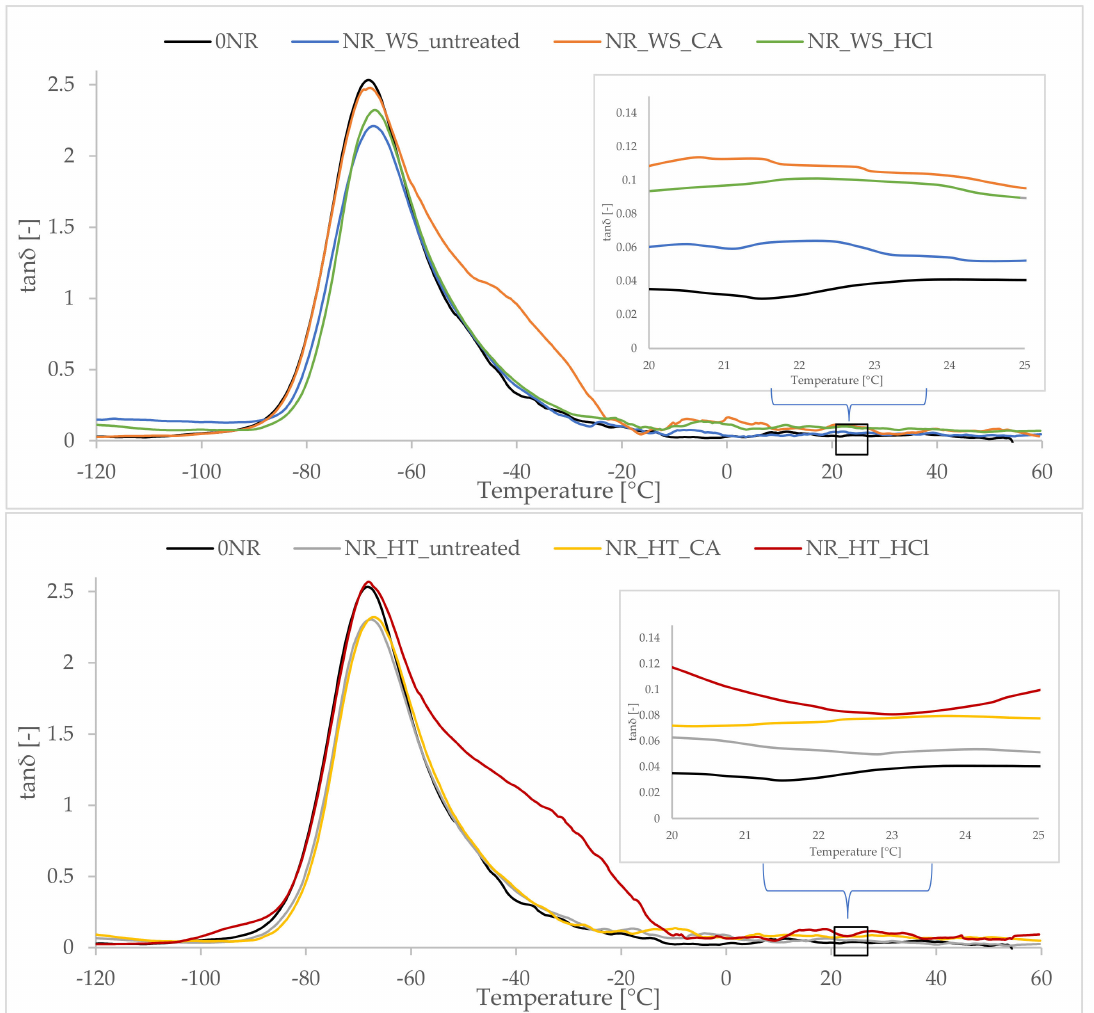
Figure 12. Mechanical loss factor as a function of temperature for the composites containing